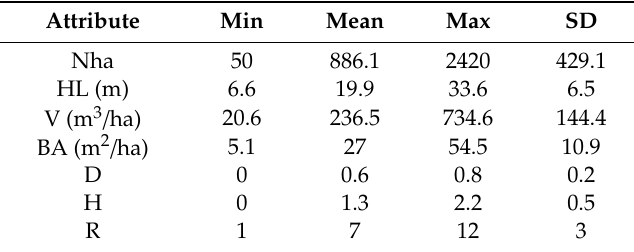
Table 1. Summary statistics for forest inventory and diversity index attributes. N = 84.